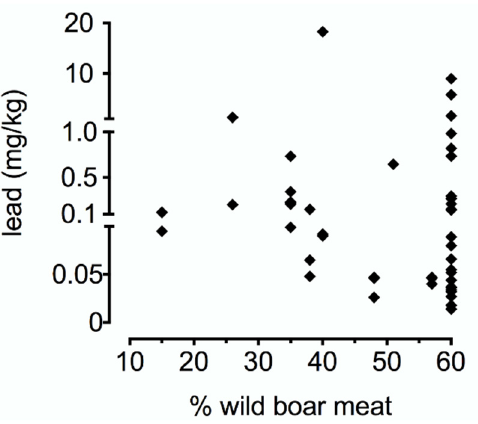
Figure 1 . Correlation between the percentage of wild boar meat in ragù samples and lead levels. Figure 1. Correlation between the percentage of wild boar meat in rag ù samples and lead